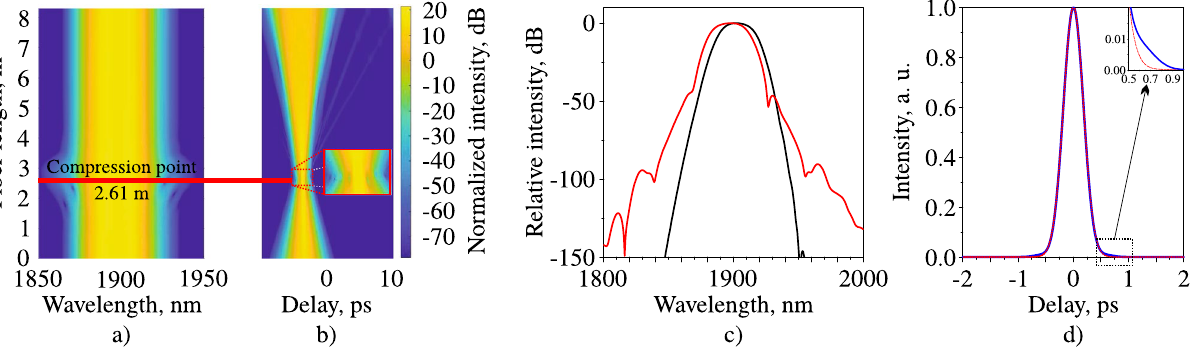
Figure 7. ( a ) Spectral and ( b ) temporal pulse evolution on the output SMF-28 fibre length, spectrum at the laser output ( c , black curve), spectrum at the compression point ( c , red curve), autocorrelation trace at the compression point ( d , blue curve), Gaussian fit ( d , red dotted